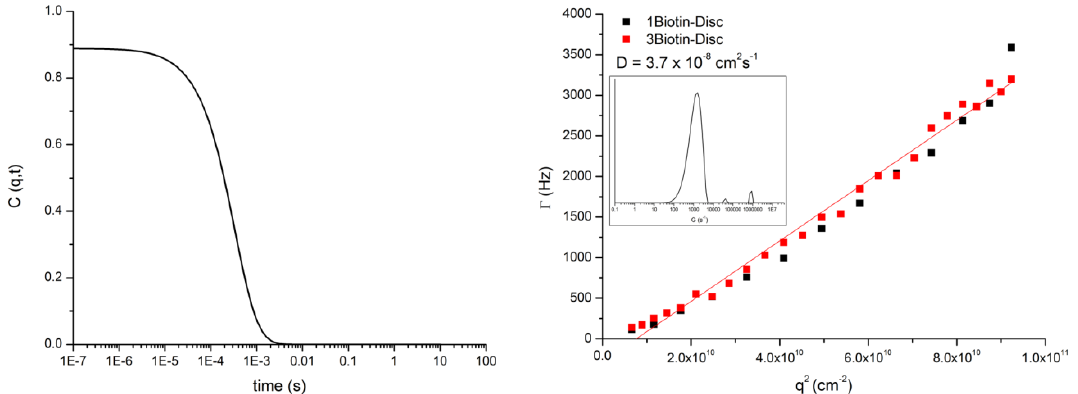
Figure 6. Left : Plot of the autocorrelation function of the 1Biotin-Disc at the 90° angle. Right : Plot of q2 vs. gamma of 1Biotin- and 3Biotin-Disc . From the q2 vs. gamma plots, the diffusion coefficient was extracted. The inset shows the distribution of species at the 90° angle for the 1Biotin-Disc